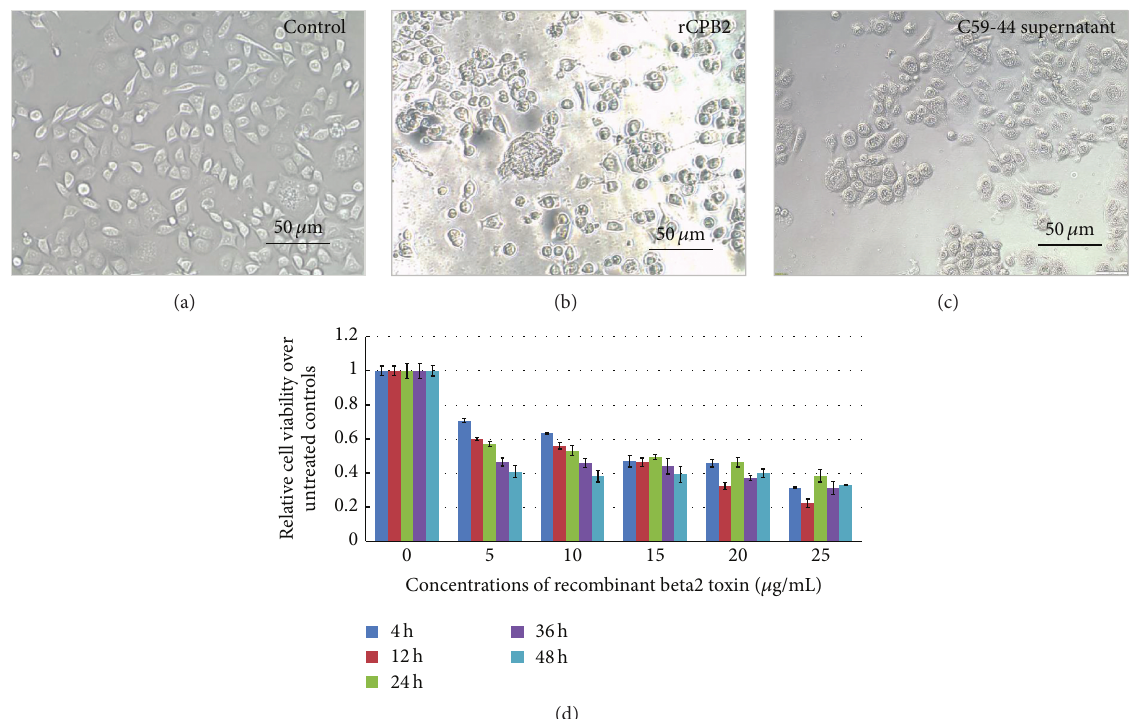
Figure 2: The cytotoxicity of rCPB2 toxin in human colon NCM460 cells. The cytotoxicity of purified rCPB2 protein was ascertained by determining its concentration causing 50% cell death (cytotoxicity 50, CT50) in a given time point in terms of an MTT assay. (a) A representative image ( × 400) of control NCM460 showed normal morphology of cells. (b) A representative image of NCM460 cells treated with rCPB2 at 20 𝜇 g/mL for 12h exhibited a morphological change of cell death. (c) A representative image of NCM460 was treated for 12h with supernatant of C. perfringens C59-44 strain. (d) The viability of NCM460 cells treated with indicated concentrations of rCPB2 for indicated times determined by an MTT assay. The data was expressed as the mean ± SD of fold changes of viable cells against the control untreated cells from three triplicated independent experiments. Bars in (a) and (b): 50 𝜇